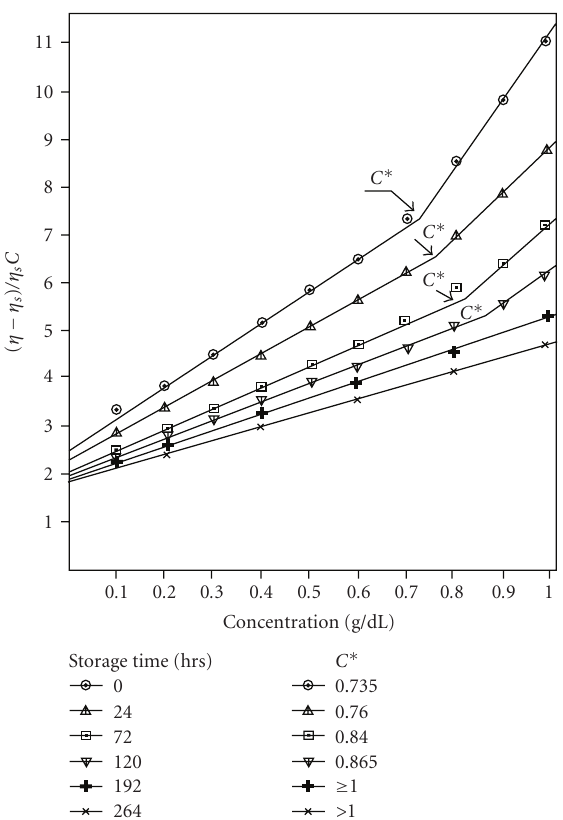
Figure 5: Viscosity of chitosan (CHT-3) solution as a function of storage time.